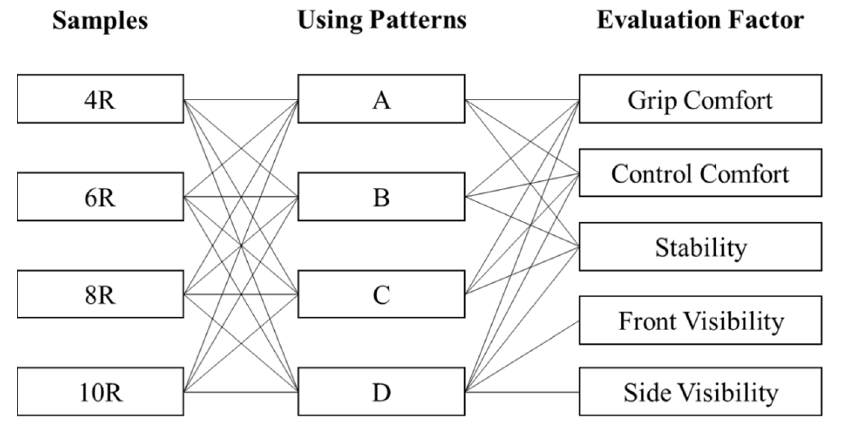
Figure 3. Experiment design of the study.